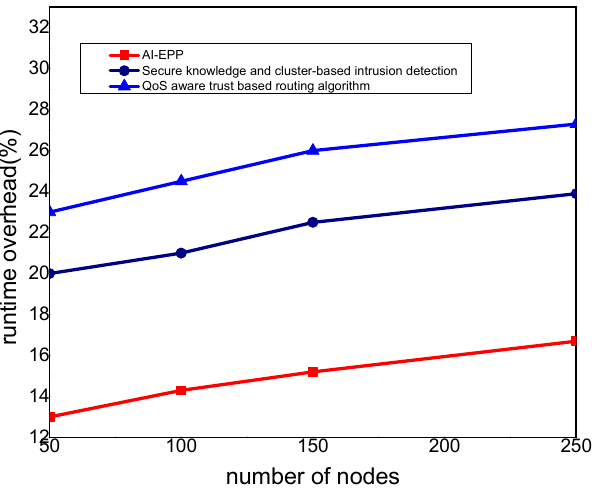
Figure 11. Runtime overhead comparison using simulations with varying number of nodes.